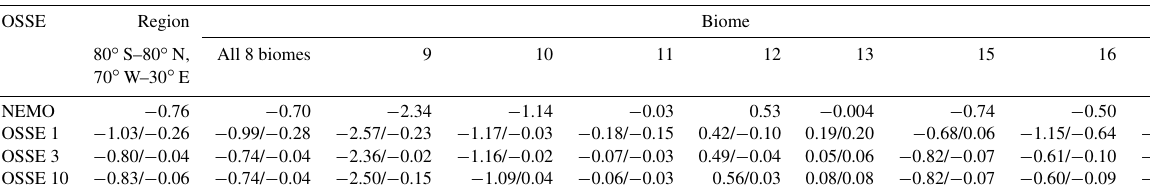
Table 8. fg CO 2 averaged over the region 80 ◦ S–80 ◦ N, 70 ◦ W–30 ◦ E and biomes from Fig. 2 for the NEMO/PISCES model; OSSEs 1, 3, 4, and 10; and the corresponding averaged differences between each OSSEs and NEMO/PISCES (in Pgyr − 1 ).